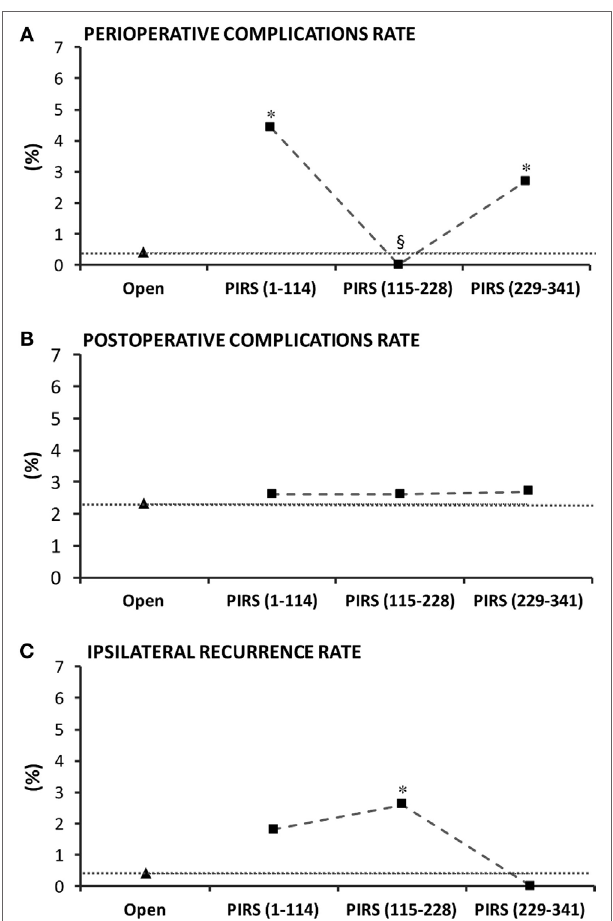
FigUre 3 | Department-centered analysis of the learning curve of percutaneous internal ring suturing (PIRS) technique considering (a) perioperative and (B) postoperative complications rates and (c) ipsilateral recurrence rate. p < 0.05 indicated significance: * vs. open; § vs. lap (0–114).